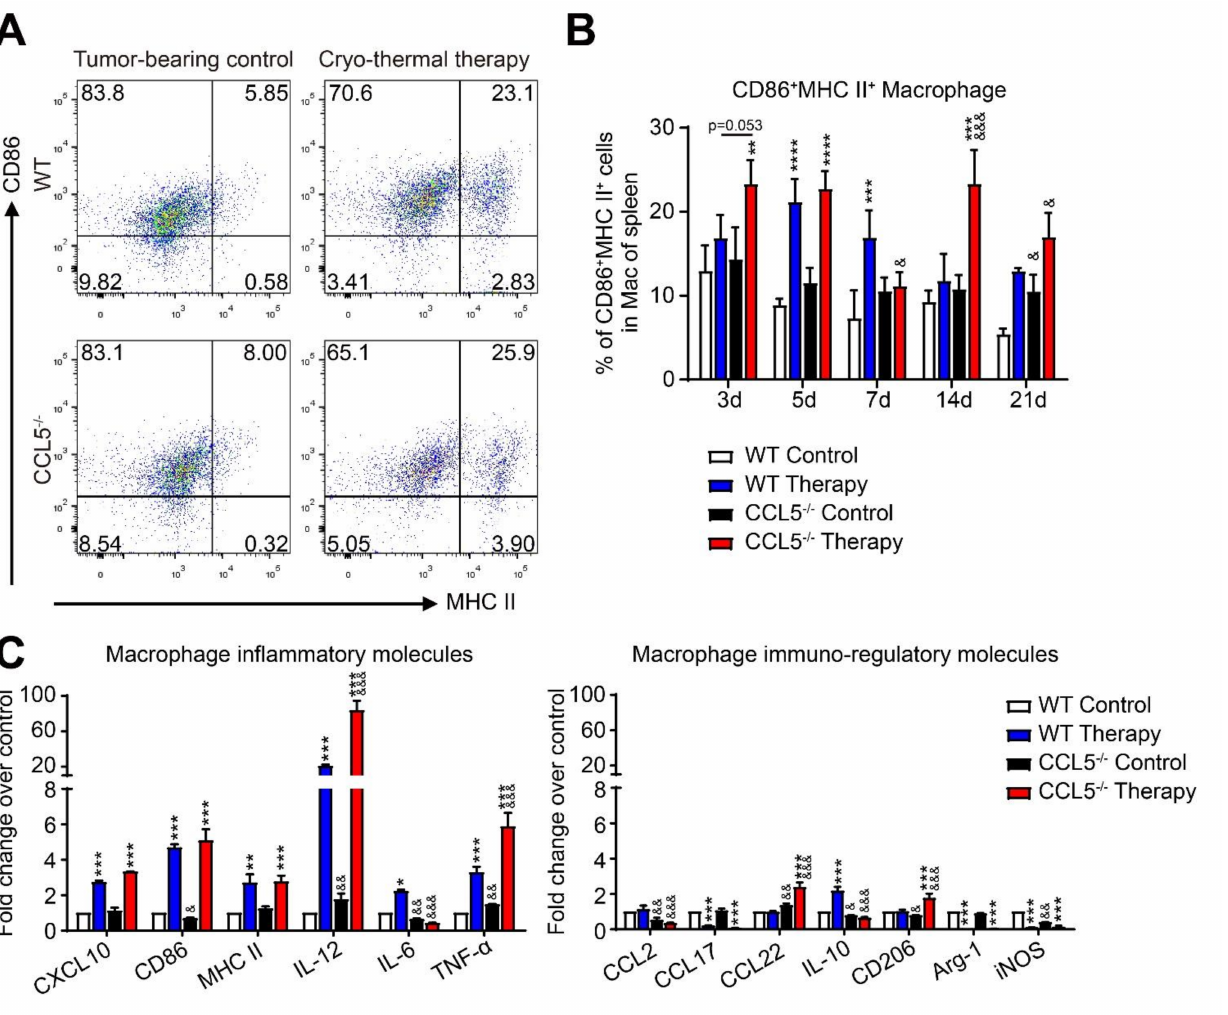
Figure 3. CCL5 deficiency promoted M1 macrophage polarization at an early stage after therapy. ( A , B ) FACS gating strategy ( A ) and analysis of the percentage of M1 macrophages ( B ) in the spleen were performed at indicated time points (3, 5, 7, 14 and 21 after therapy). ( C ) The expression of inflammatory and immune-regulatory molecules of macrophages were detected with qRT-PCR. Total RNAs were isolated from splenic CD68 + macrophages in treated mice or tumor-bearing mice. n = 4 per group; mean ± SD. The data of FACS were analyzed with FlowJo 7. * p < 0.05; ** p < 0.01; *** p < 0.001; **** p < 0.0001, compared to WT tumor-bearing control or CCL5 − / − tumor-bearing control. & p < 0.05; && p < 0.01; &&& p < 0.001, compared to WT